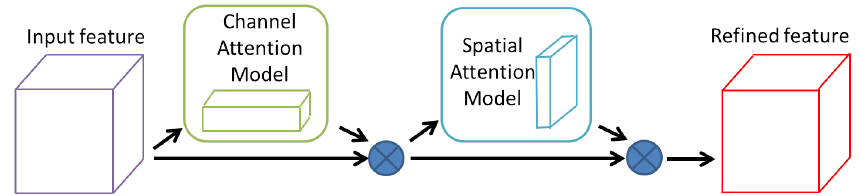
Figure 5. The Convolutional Block Attention Module.